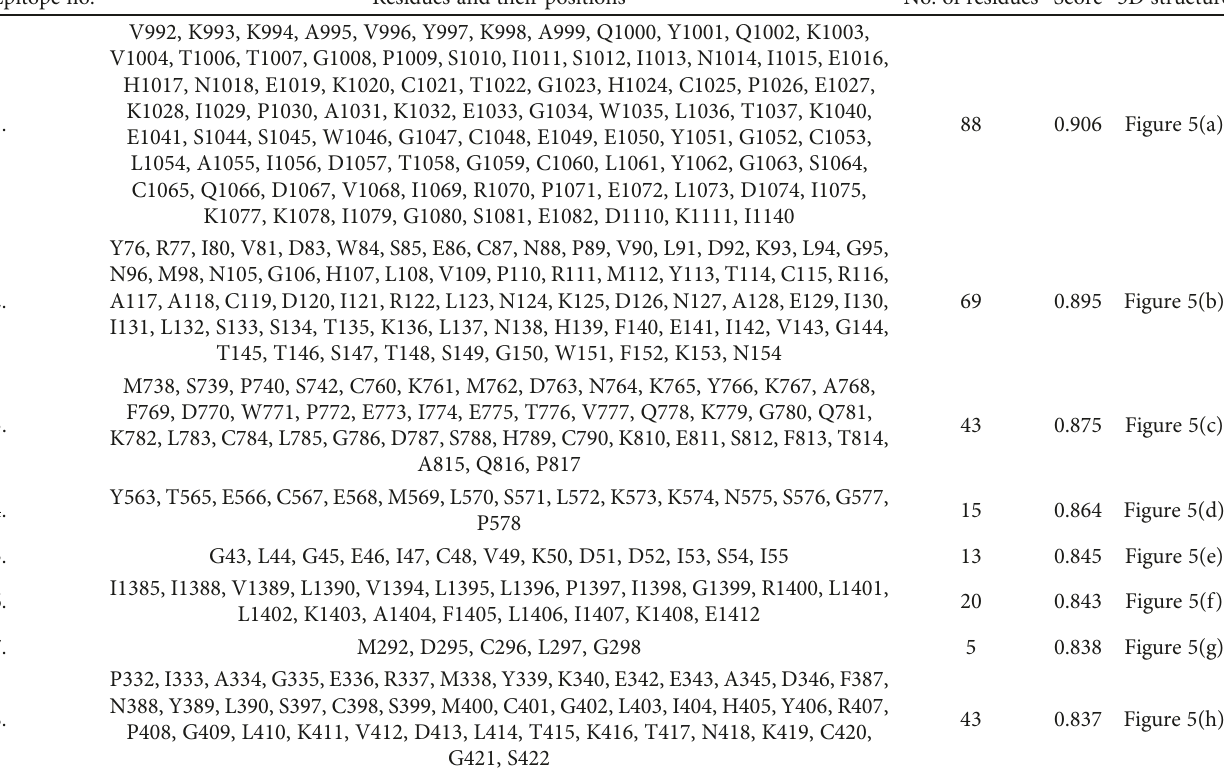
Figure 5: Three-dimensional representation of conformational or discontinuous epitopes (a – h) of the highest antigenic polyprotein of OROV. The epitopes are represented by yellow surface, and the bulk of the polyprotein is represented in grey sticks. Table 6: Predicted conformational B-cell epitopes of the polyprotein of OROV. Epitope